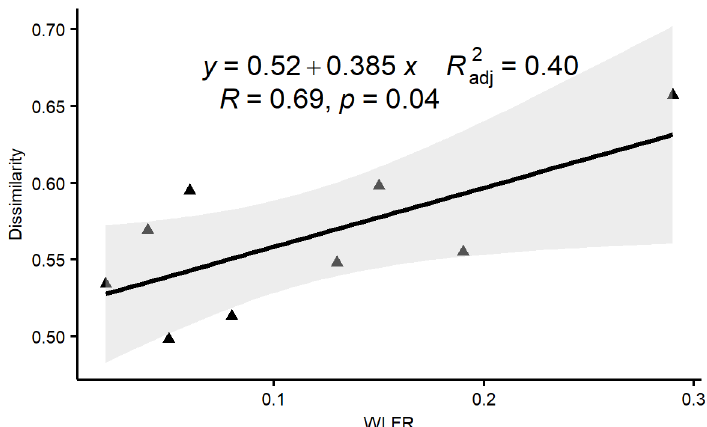
Figure 2. Correlation between the dissimilarity of macroinvertebrate assemblages in two consecutive sampling events and the monthly water level fluctuation range (WLFR) (the solid line represents the estimated regression line for the dataset with outlier omitted).